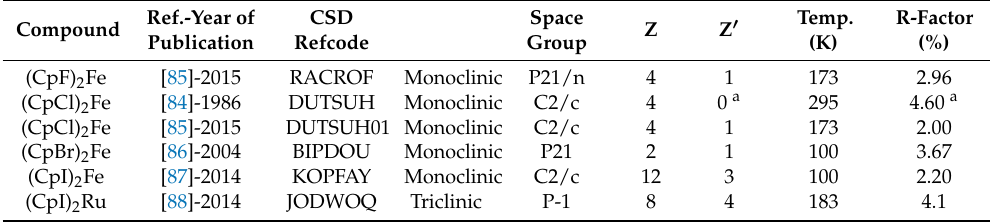
Table 1. Results from the CSD search on group VIII 1,1 ′ -halometalocenes.